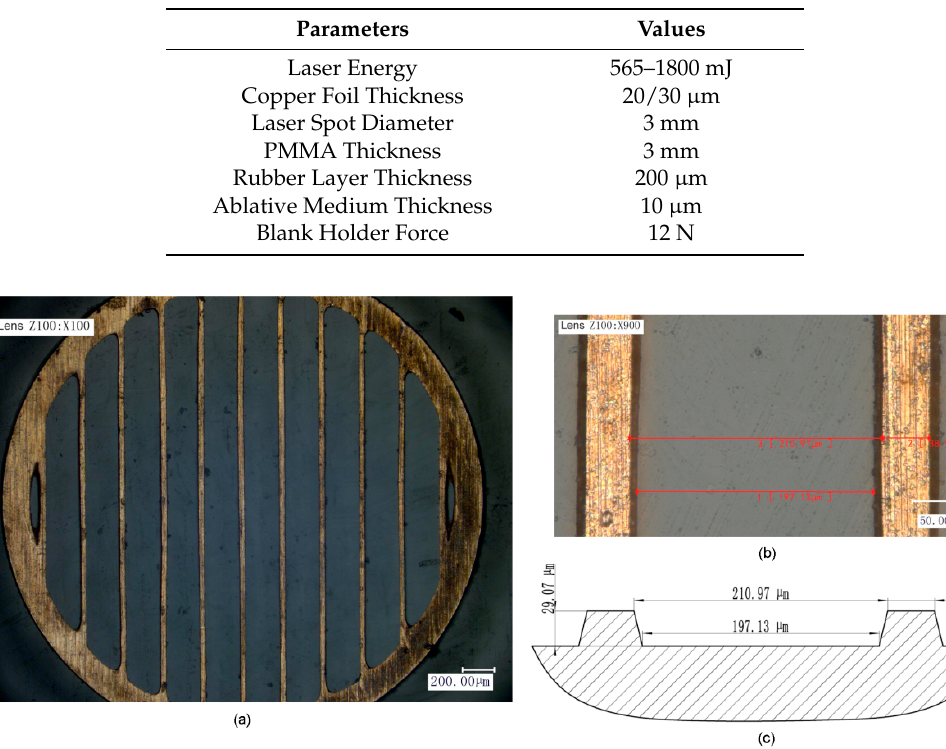
Figure 2. ( a ) Two ‐ dimensional (2 ‐ D) morphology of the whole micro ‐ die , ( b ) 2 ‐ D image of a single cavity of the micro ‐ die , and ( c ) sectional view and dimension of a single cavity of the micro ‐